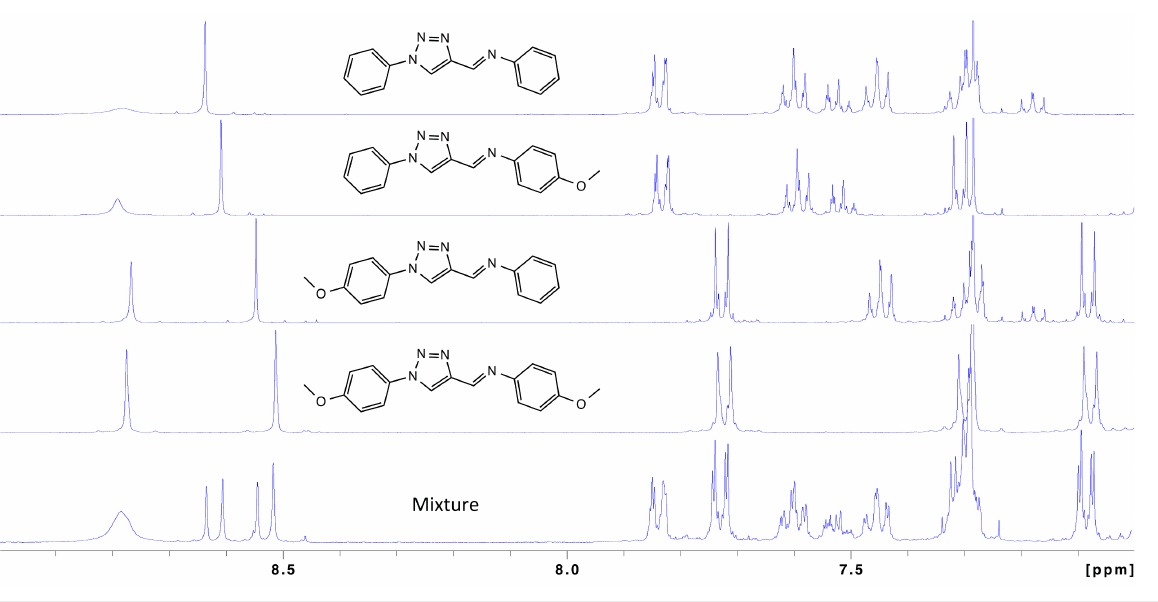
Figure 3: 1 H NMR aromatic region of a product mixture compared with reference imine analogs. Singlets appearing from 8.5–8.7 ppm correspond to the triazole C–H position used to quantify the imine constituents of product